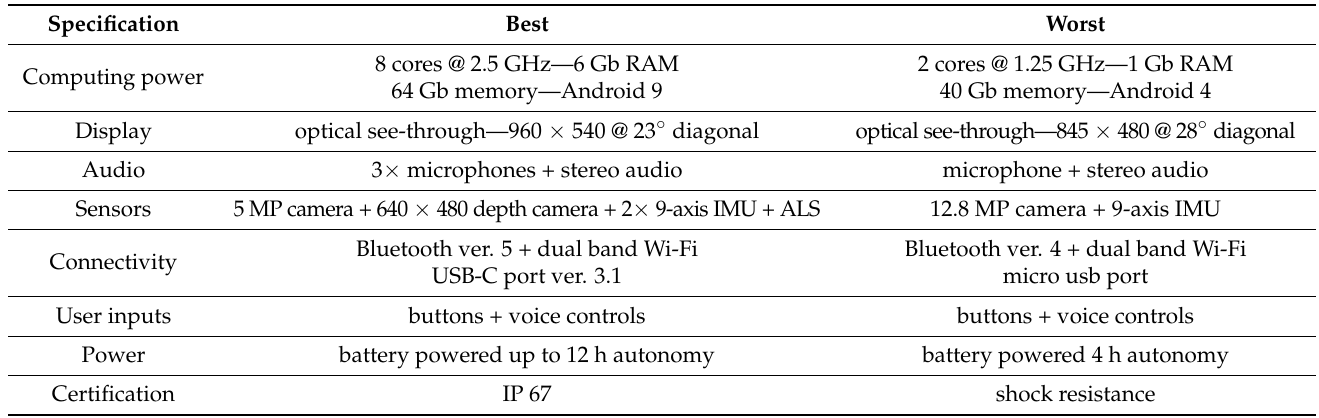
Table 3. Industrial HDM specifications.